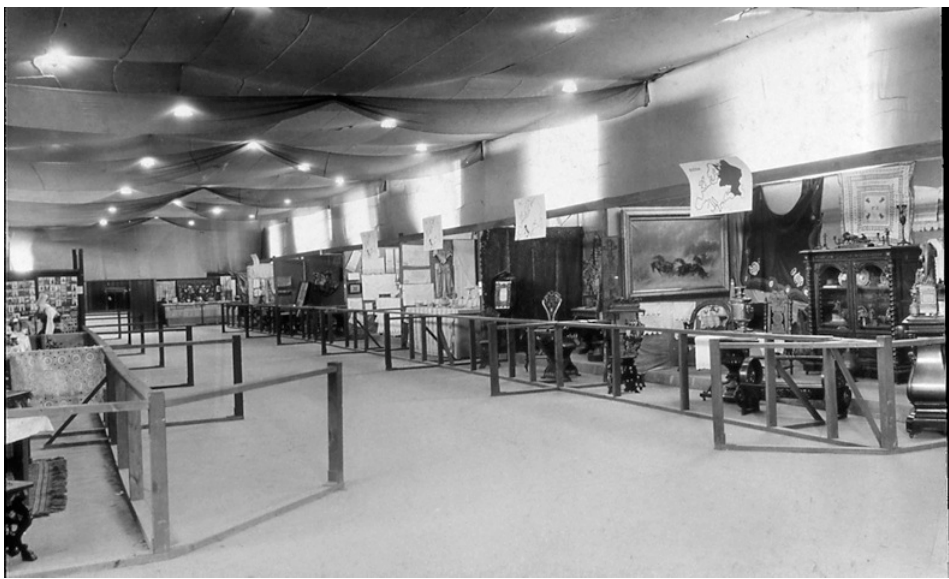
Unknown photographer, exhibit booths in right aisle at the Rochester Arts and Crafts of the Homelands exhibition held April 10-19, 1920 on the grounds of Exposition Park in Rochester, NY. Memorial Art Gallery, University of Rochester